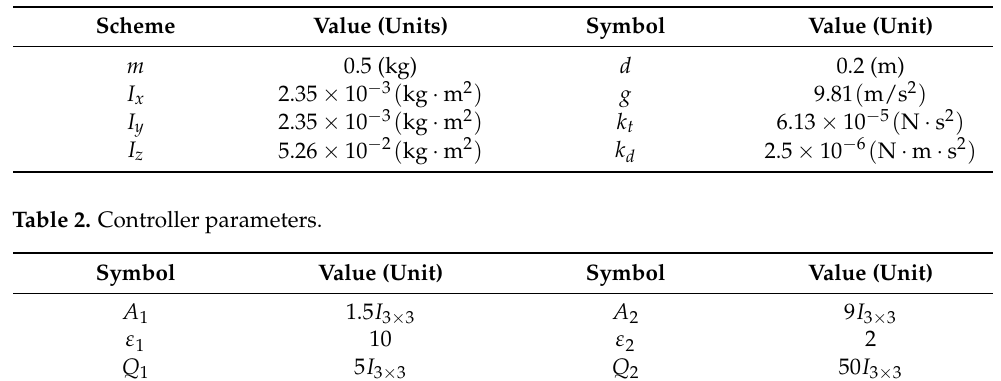
Table 1. Model parameters of quadrotor.